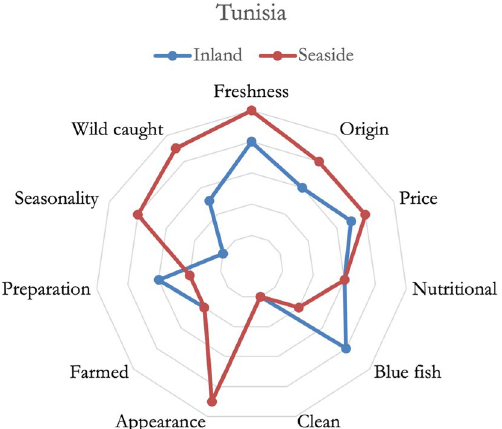
Fig. 3 Importance of fish attributes in defining consumers’ preferences,